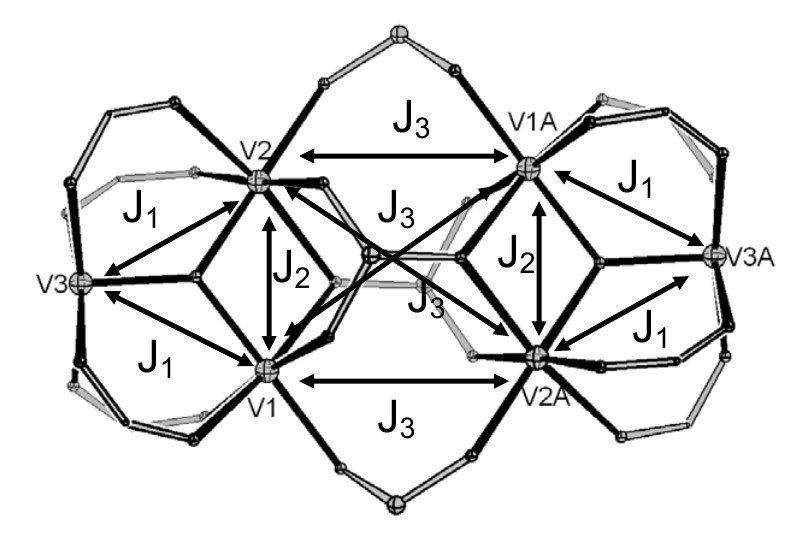
Figure 5. Model for exchange coupling in complex 3